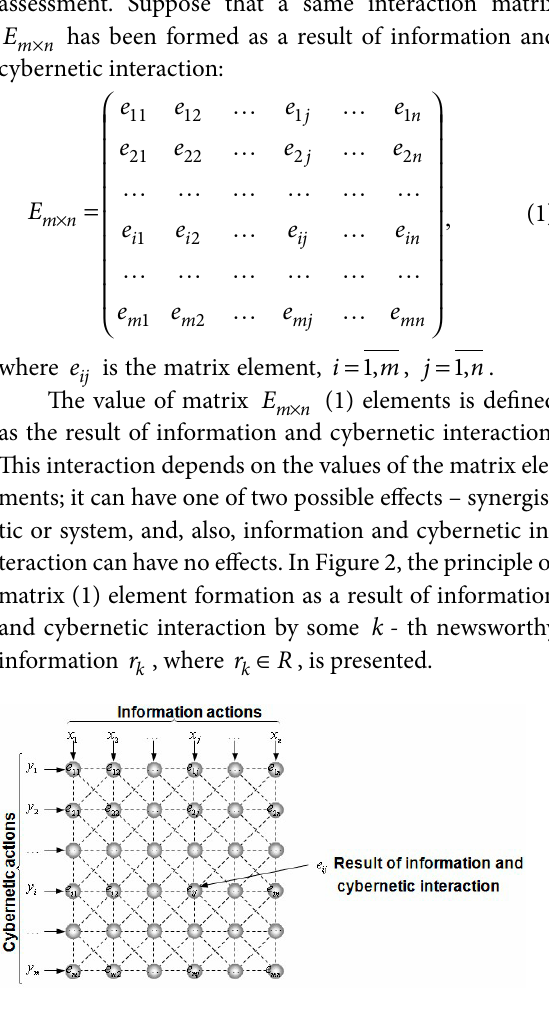
Fig. 2. Principle of interaction matrix element